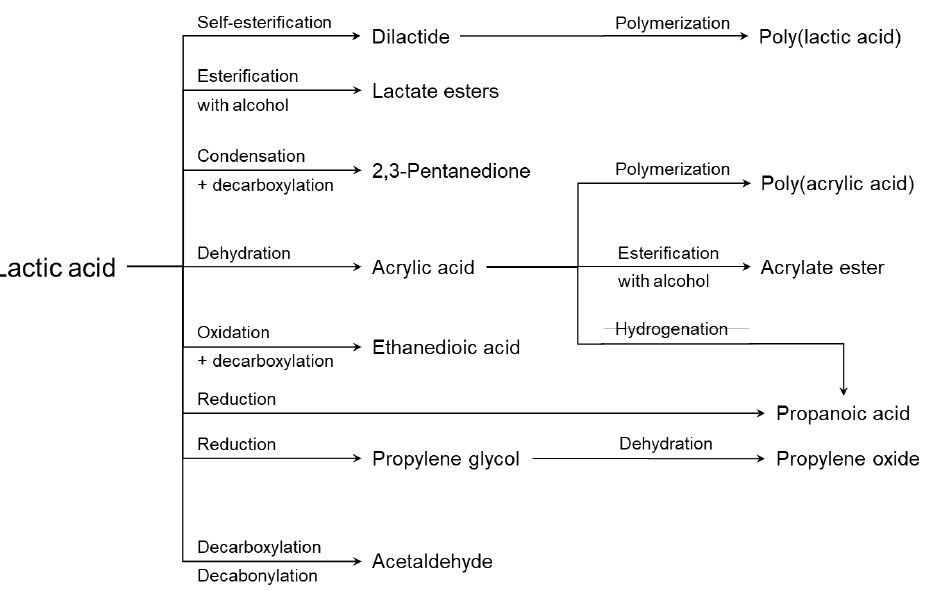
Figure 3. Lactic acid as a precursor molecule for the synthesis of industrially important chemicals.